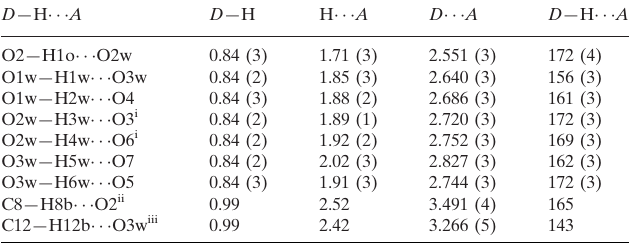
Hydrogen-bond geometry (A˚ , (cid:3)